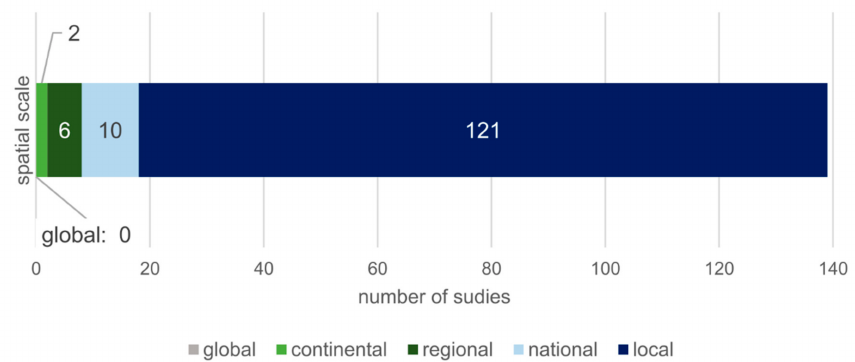
Figure 4. Number of EO-based forecast studies according to spatial scale of the study area.